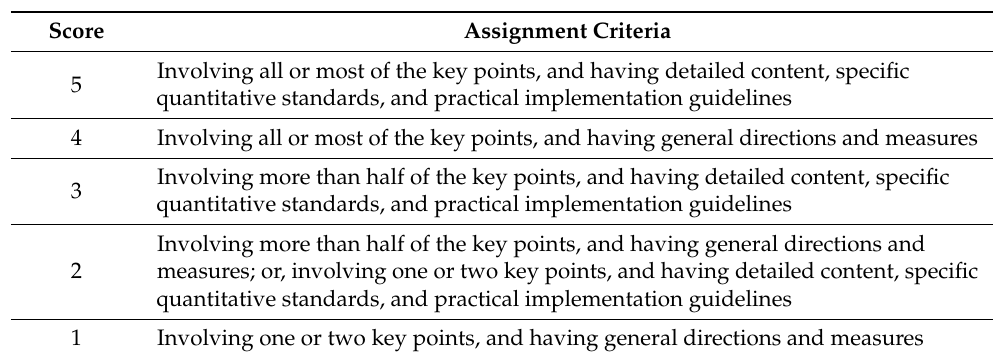
Table 4. Criteria of policy